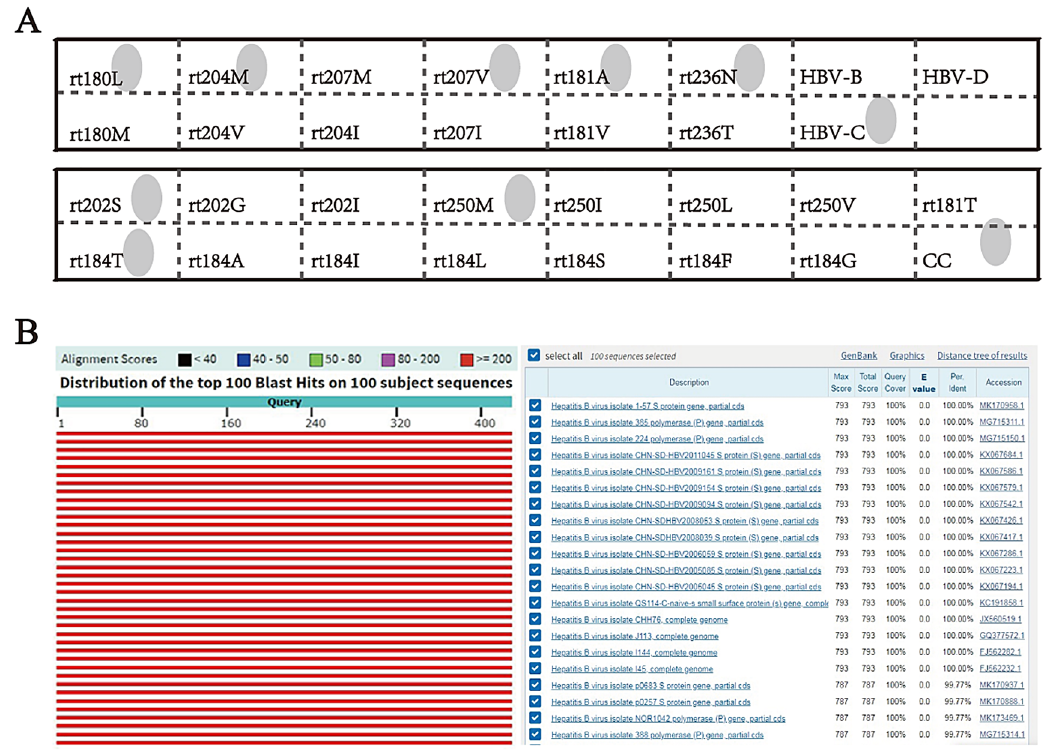
Figure 2: Verification experiments for the conflicting HBV DNA quantification results. (A) The serum on February 13th was examined by HBV genotyping and drug resistant mutations assay. The specific HBV sequences were amplified by PCR, followed by hybridization with probes fixed on nylon membrane and then produced a color reaction with tetramethylbenzidine. (B) The serum on February 13th was verified by Sanger sequencing. The sequencing primers were designed in the S region and the products were 429 bp long. Sequencing data was analyzed on NCBI Blast with graphic display (left panel) and hit list (right